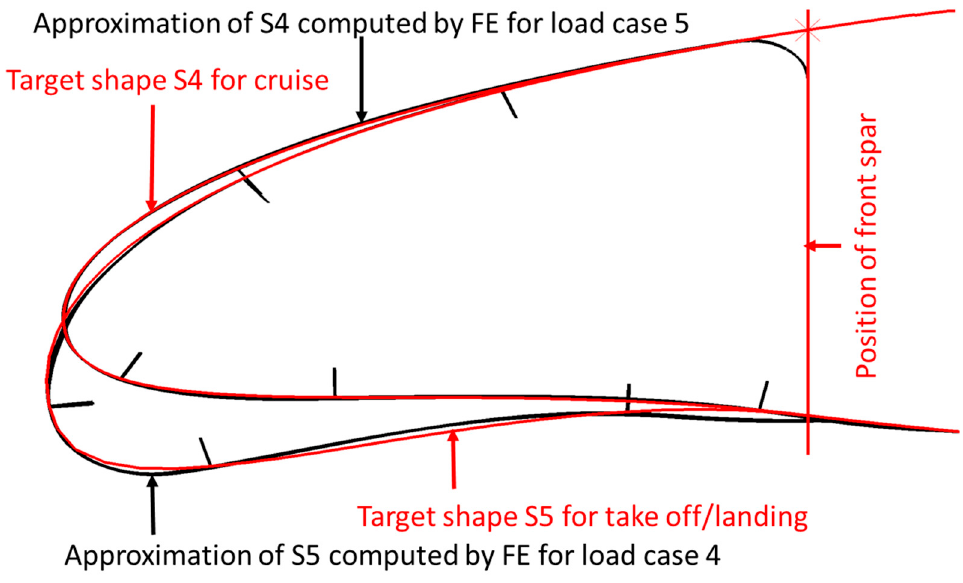
Figure 16. Achieved approximation of target shapes computed by FE model for load cases 4 and 5.